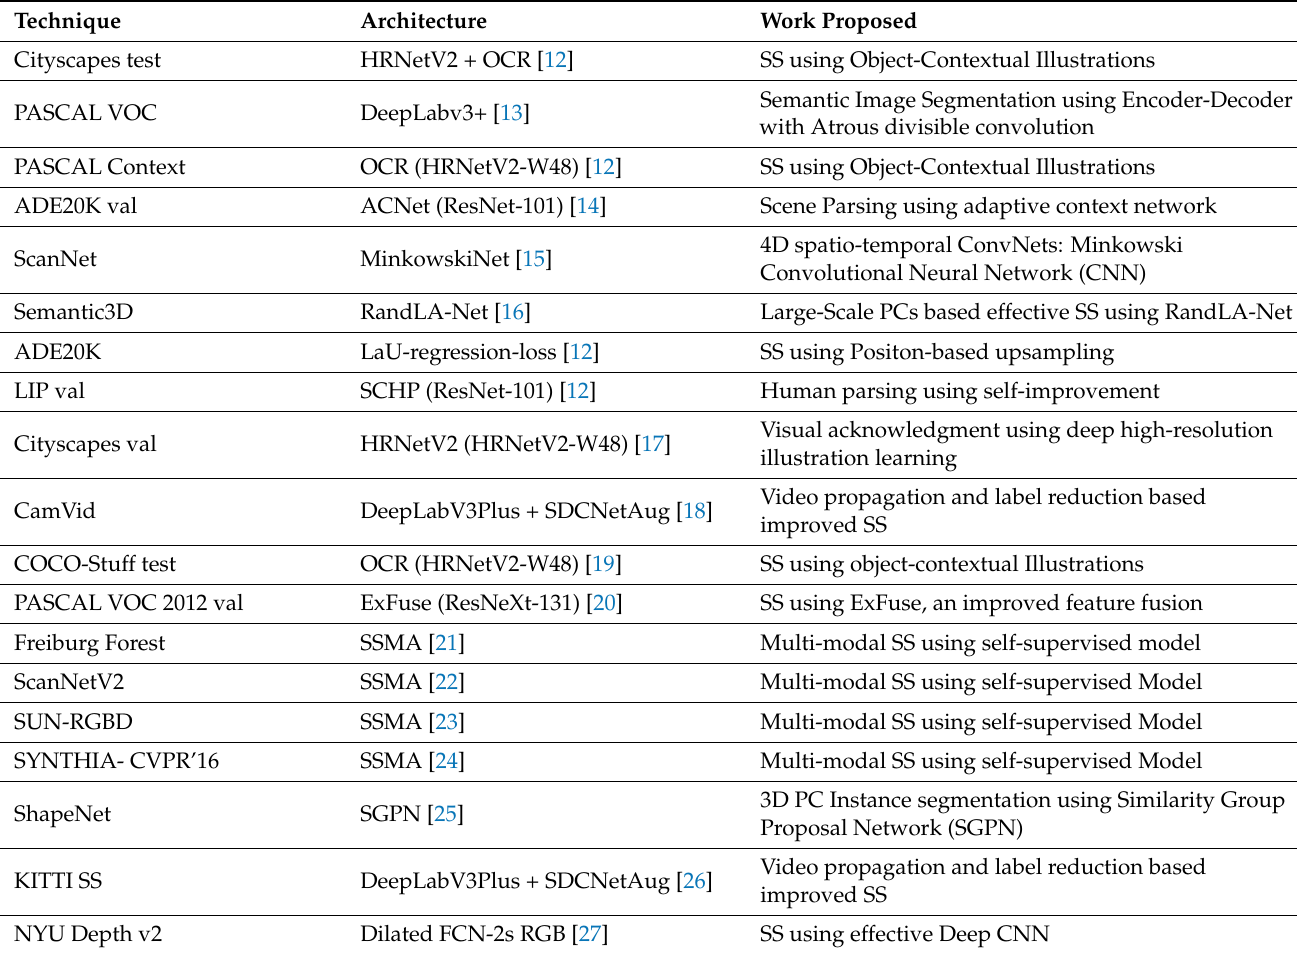
Table 1. Architectures used in path